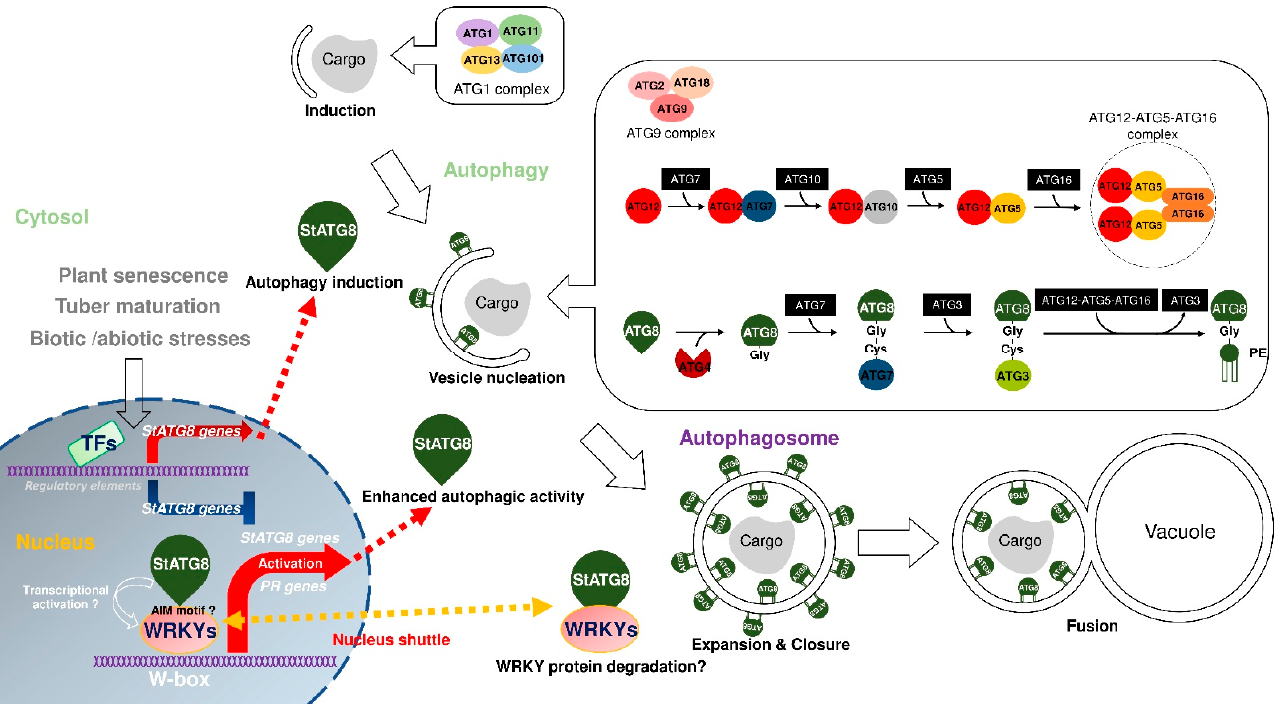
Figure 7. A model for the functional diversification of potato StATG8 under multiple stress condi- tions. The model for autophagy formation and ATG8 gene activation was inspired by following papers [50,56,76,77].